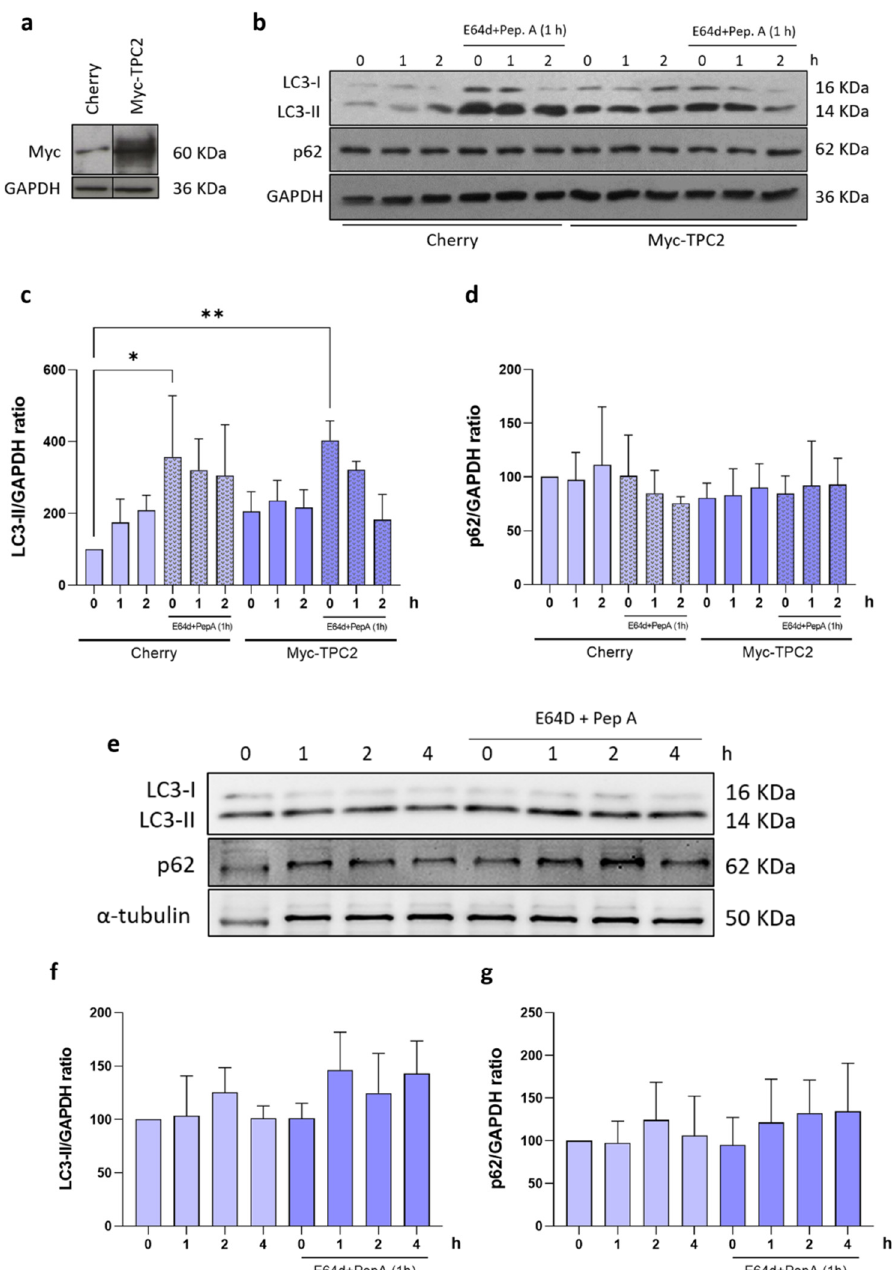
Figure 3. Evaluation of NAADP-induced autophagy in astrocytes overexpressing TPC2 or mHtt-Q74. Western blot analysis of the autophagic flux of astrocytes overexpressing Myc-TPC2 or pEGFP-mHtt-Q74 after treatment with NAADP-AM (100 nM), in the presence or absence of E64d/Pep A. Detection of autophagy was performed by analyzing the levels of LC3 and p62 levels after 1, 2 and 4 h of treatment with NAADP. ( a ) Representative autoradiograms of western blotting analysis of anti-myc and anti- GAPDH antibodies, demonstrating Myc tag protein overexpression in astrocytes transfected with the Myc-TPC2 construct. ( b ) Representative autoradiograms of western blotting analysis of anti-LC3, anti-p62 and anti-GAPDH antibodies in the astrocytes overexpressing Myc-TPC2. ( c ) Quantification of LC3-II and ( d ) p62 after treatments with NAAPD-AM in astrocytes overexpressing Myc-TPC2, both in the presence or absence of E64d/pepstatin A. The experiments were normalized in relation to the GAPDH internal control. n = 3. Data presented as mean ± SEM, One-way ANOVA followed by